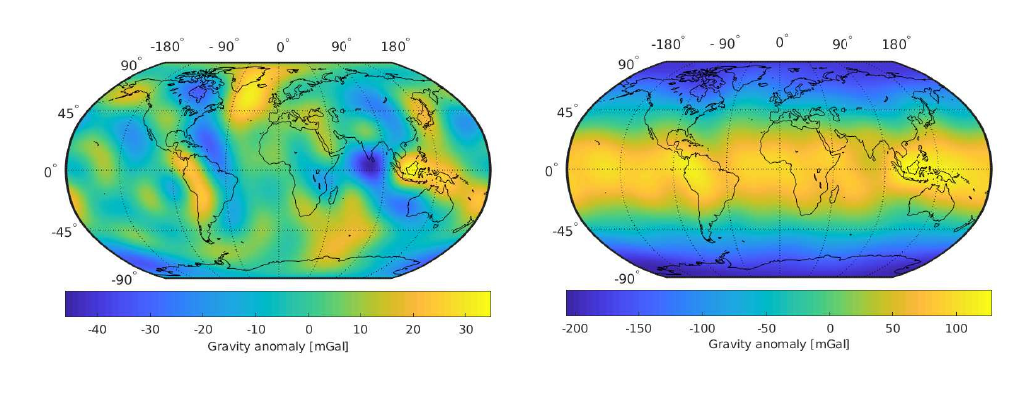
Figure 2. True (GGM05S) gravity field ( left ) and initial gravity field ( right ) in terms of gravity anomalies up to degree and order